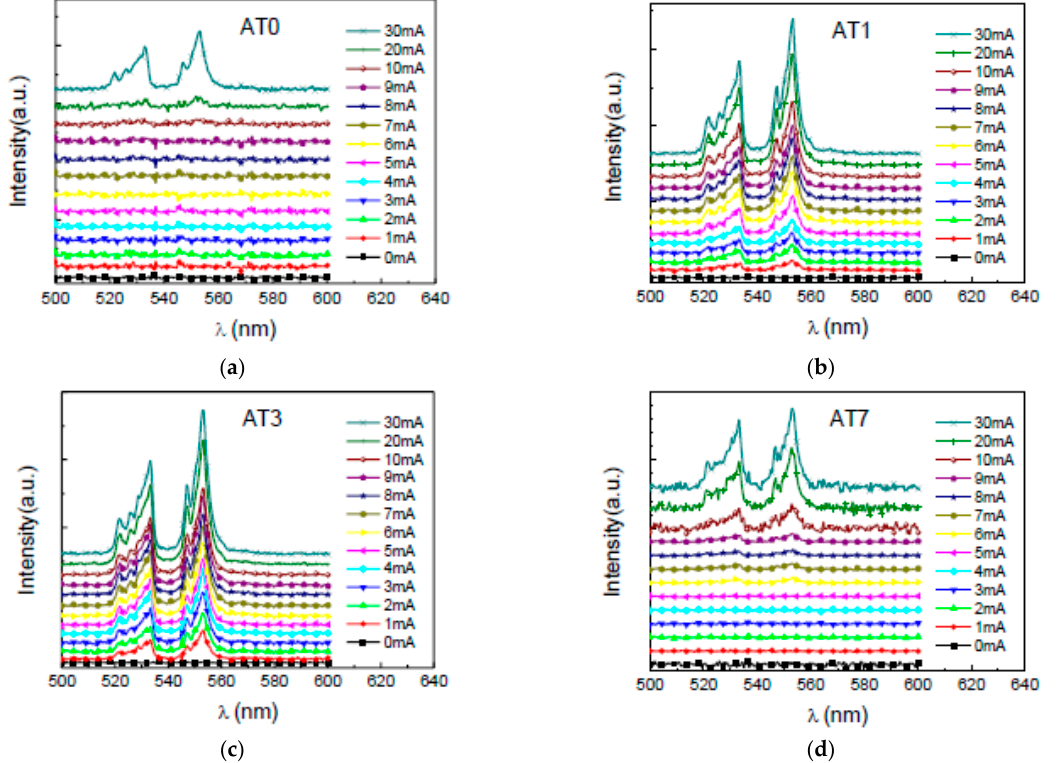
Figure 8. The luminescent spectrum of samples ( a ) AT0, ( b ) AT1, ( c ) AT3, and ( d ) AT7 under different reverse-biased injection current levels.